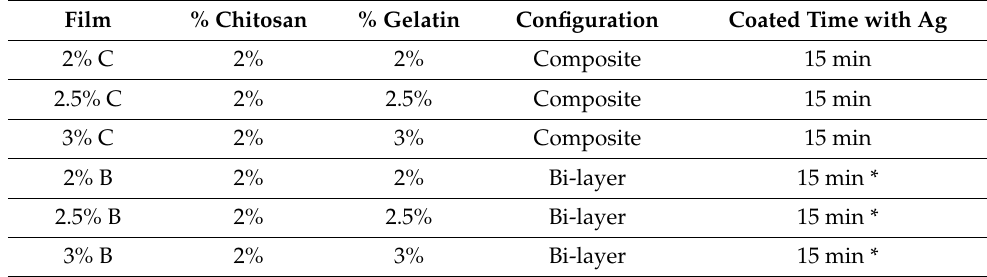
Table 1. Film’s composition and coated